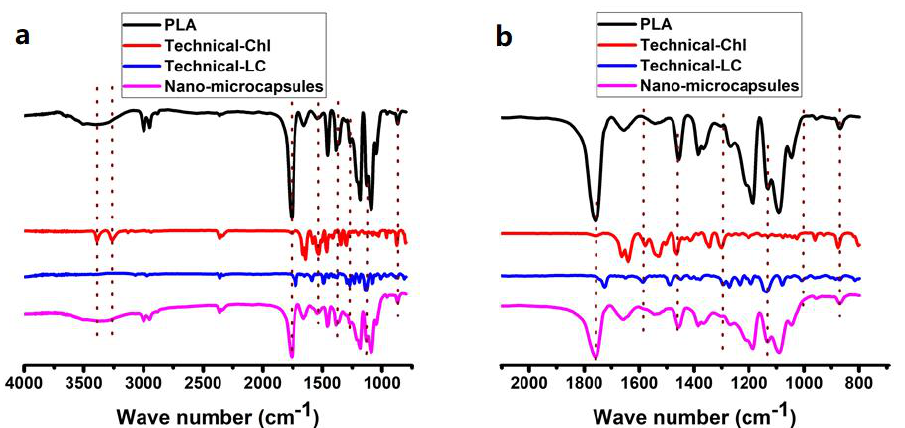
Figure 3. ( a ) Fourier-transform infrared spectra of polylactide (PLA), chlorantraniliprole (Chl), lambda cyhalothrin (LC), and the double-loaded nano-microcapsules, and ( b ) magnified regions of the spectra.